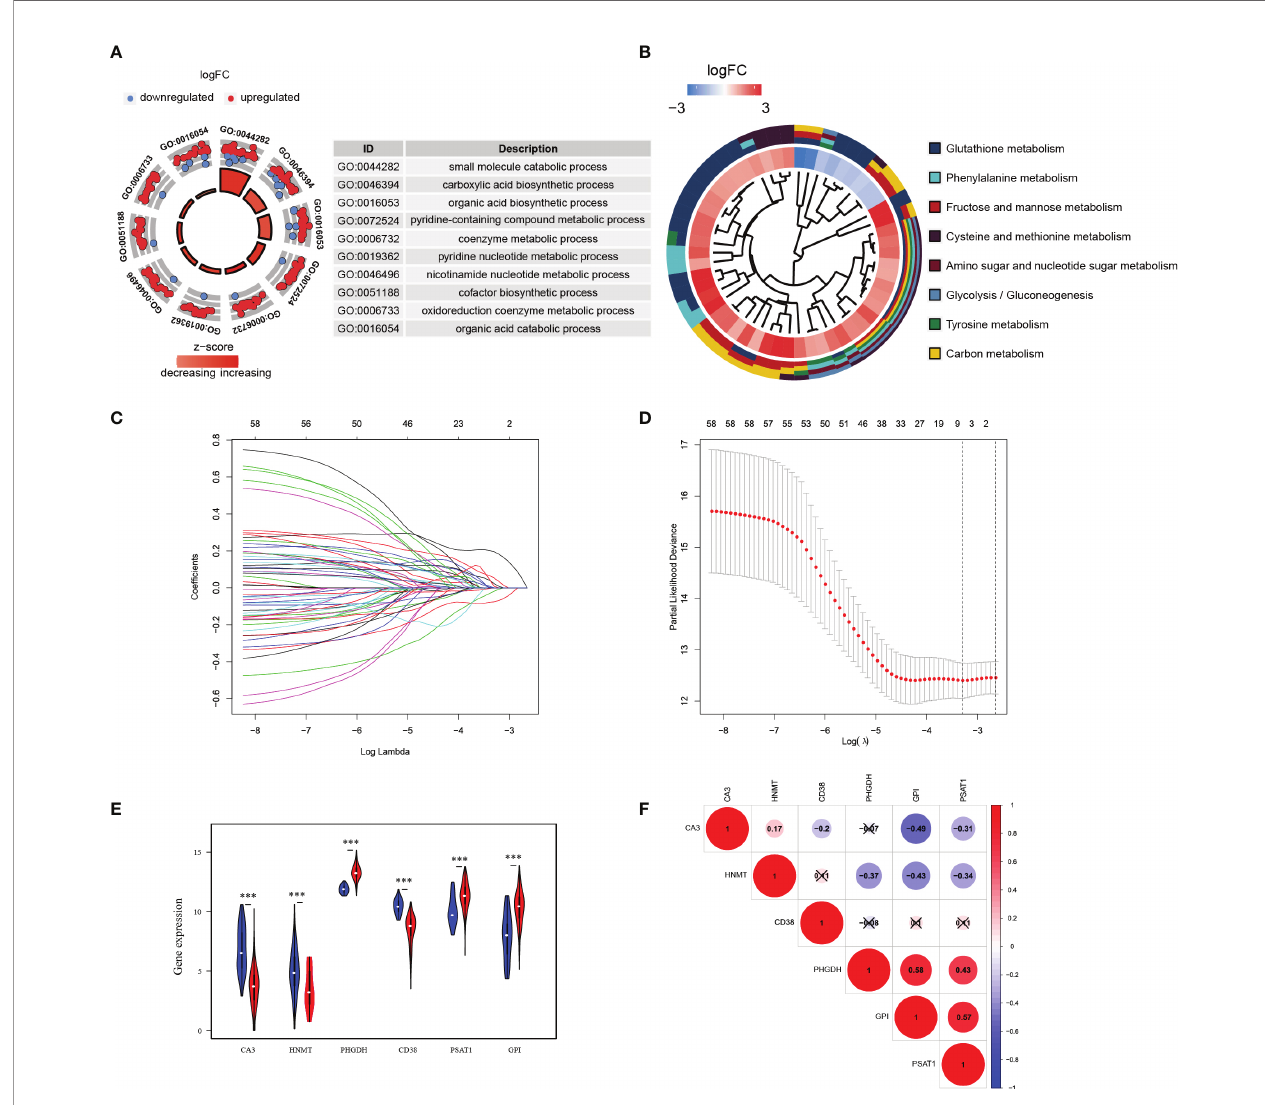
FIGURE 2 | Functional enrichment analysis and prognostic genes constructed by the overlapping DEGs. (A) GO analysis of 61 metabolism-related DEGs, with only top 10 terms of BP, CC, and MF being shown; (B) KEGG analysis of 61 DEGs. The inner circle is composed of different genes and their expression (LogFC) while the outer circle consists of different KEGG terms; (C) LASSO logistic regression algorithm to screen associated genes with cross-validation, where each gene has a different color; (D) The selection of six genes with the lowest misclassi fi cation error; (E) Expressions of the selected genes in different tissue samples in TCGA database. Blue dots represent gene expressions in the normal group, and red dots represent gene expressions in the EC group. (F) Spearman correlation analysis of the selected genes in TCGA